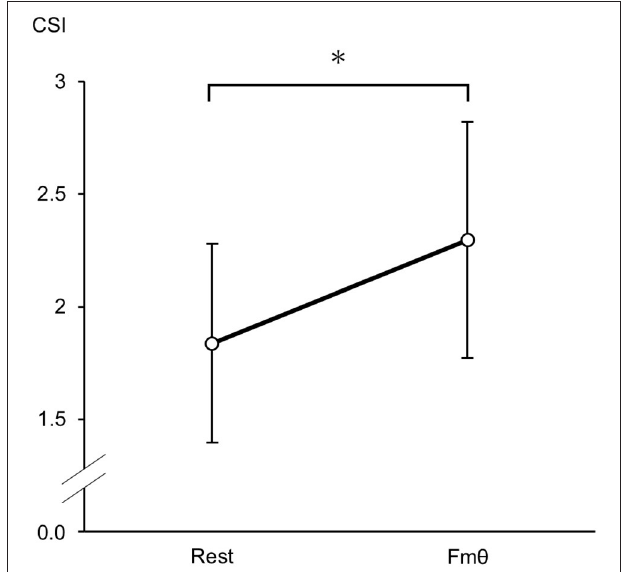
FIGURE 3 | Cardiac vagal index (CVI) changes during the rest condition and Fm θ condition. Values are expressed as means and SDs. * p < 0.05.